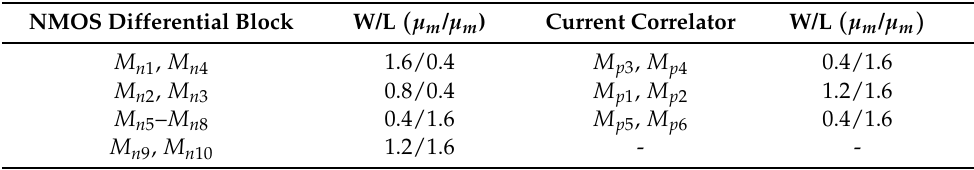
Figure 5. The utilized Gaussian function circuit is presented. The output current I out resembles a Gaussian function controlled by the input voltage V in . The parameter voltages V r , V c , and the bias current I bias control the Gaussian function’s mean value, variance, and peak value, respectively. Table 1. Bump circuit transistors’